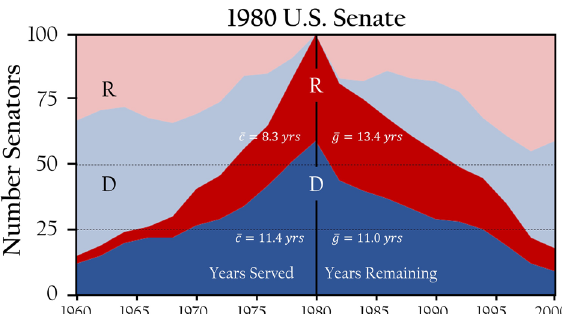
Fig. 9 Distribution of years served and years remaining by party affiliation for U.S. Senators in the 1980 U.S. Senate: Blue 59 Democrats (D); Red 41 Republicans (R). Note the average years served ( c ) and remaining = = ( g ) for members of each party. The light red and light blue-shaded regions on either side depict the proportion of the 100-senate seats filled by predecessors (on left) and successors (or